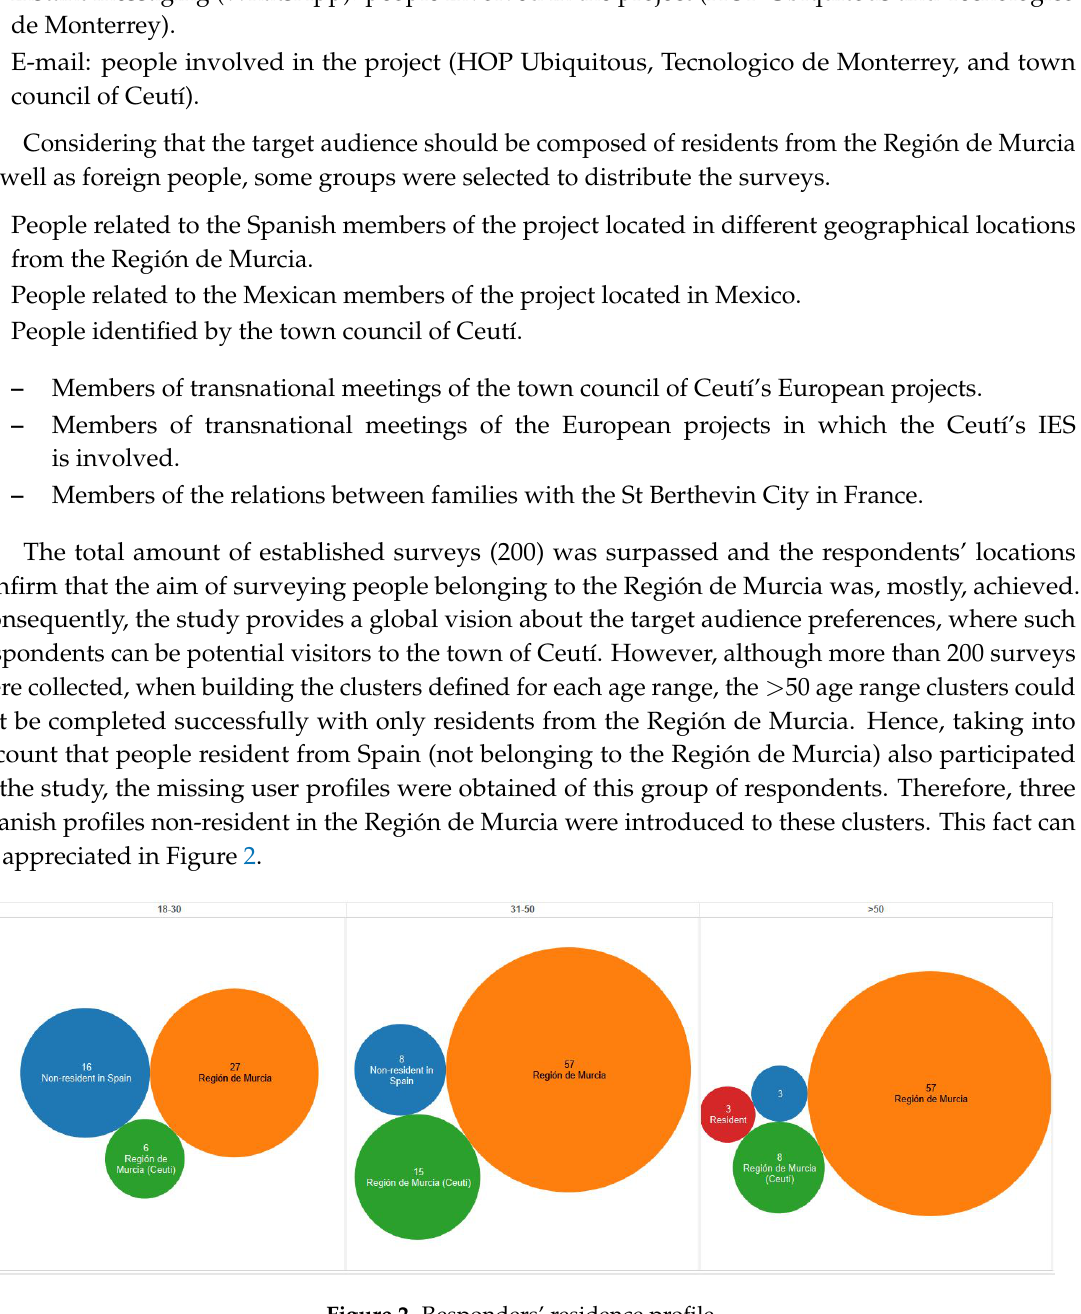
Figure 2. Responders’ residence